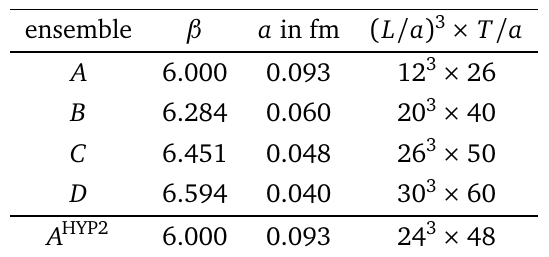
Table 1: Gauge link ensembles used in this work (physical units are introduced by = setting r 0